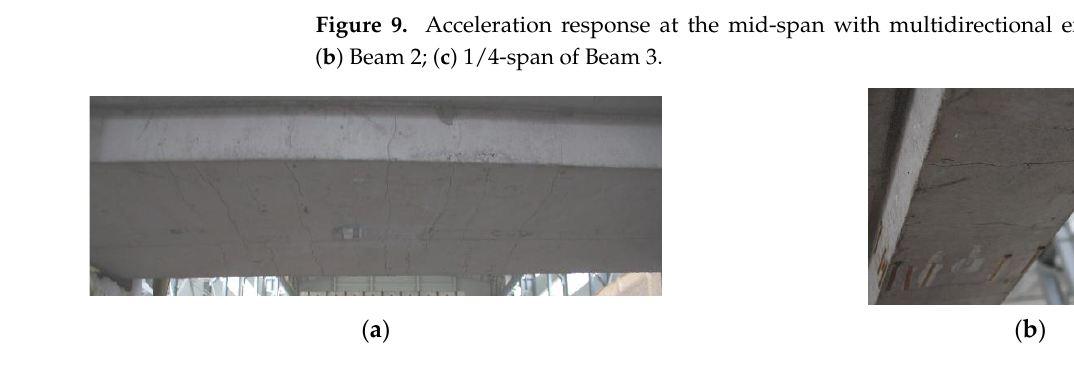
lightweight. Thus, beam 1 had a greater mid-span stress, and transverse cracks appeared